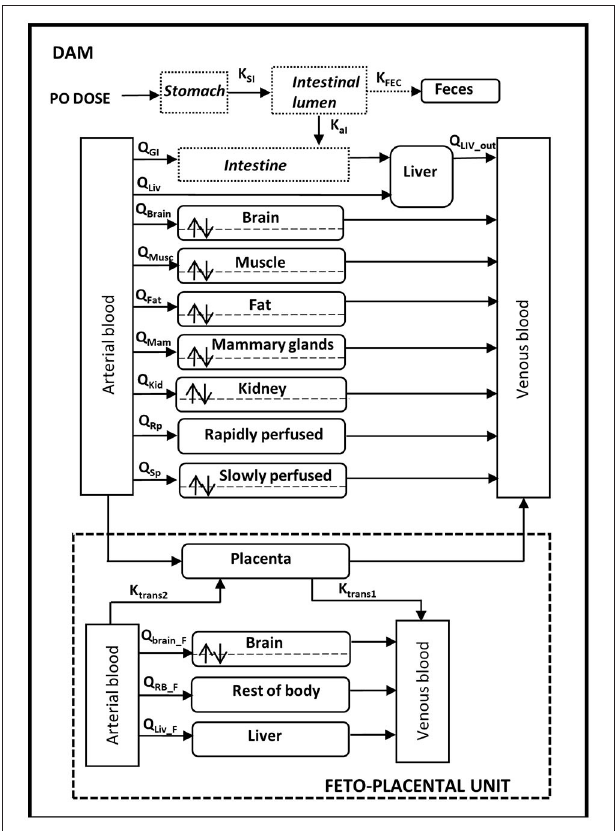
FIGURE 1 | Physiologically based pharmacokinetic model of cis - and trans -permethrin in pregnant rats and